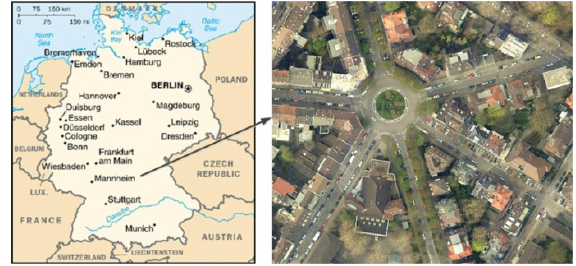
Figure 1. Study area of Mannheim, Germany